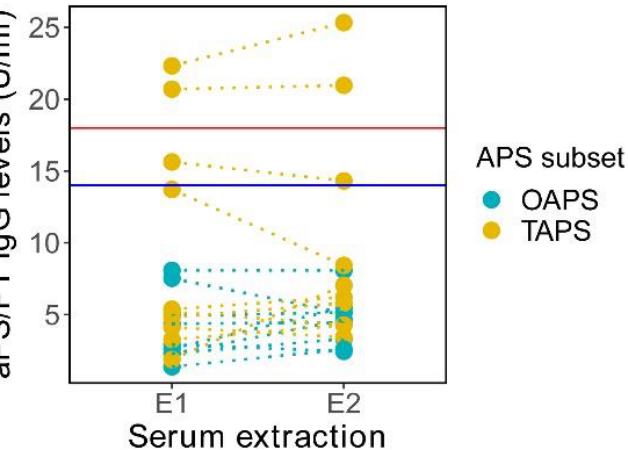
Figure 6. Antiphosphatidylserine/prothrombin (aPS/PT) IgG levels in transient seronegative obstetric (OAPS) and thrombotic antiphospholipid syndrome (TAPS) patients. Sera from transient seronegative OAPS and TAPS patients were isolated twice at least 12 weeks apart (E1 = extraction 1, E2 = extraction 2) and the IgG aPS/PT levels were measured by ELISA. Dotted lines represen both extractions of each patient. Horizontal red line denotes the threshold for aPS/PT positivity (>18 U/mL). Horizontal blue line denotes the limit for low-middle aPS/PT levels (>14 U/mL and <18 U/mL).